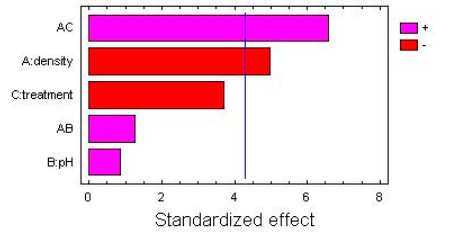
Figure 4. Standardized Pareto Chart for percentage variation of stress at break.